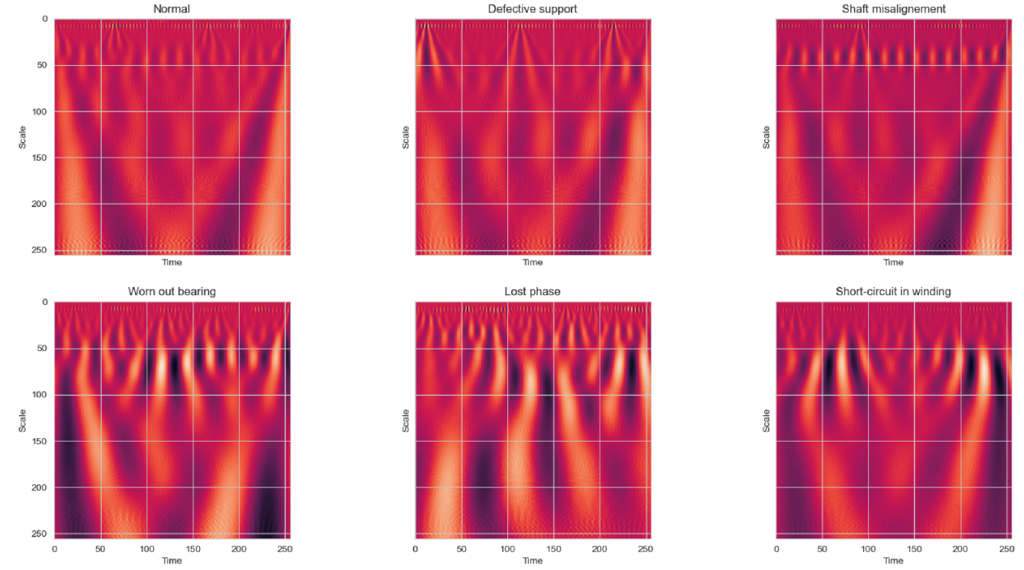
Figure 7. One sample of resulting scalograms shaped at 64 × 64 with all six classes.